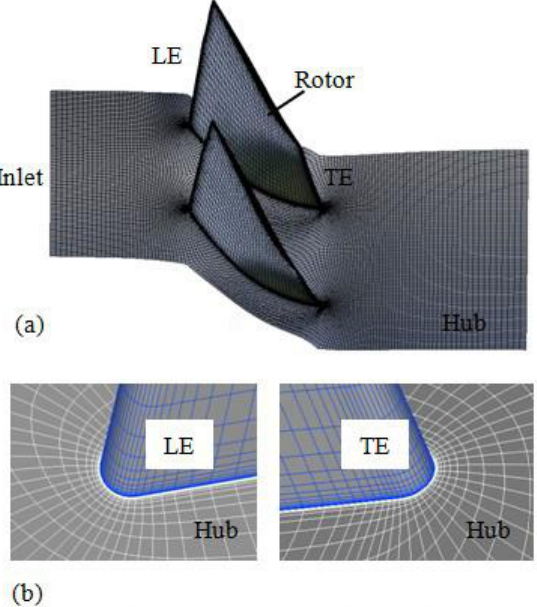
Figure 5. NUMECA FINE computational mesh. ( a ) Perspective view and ( b ) View from casing at LE and TE of hub.